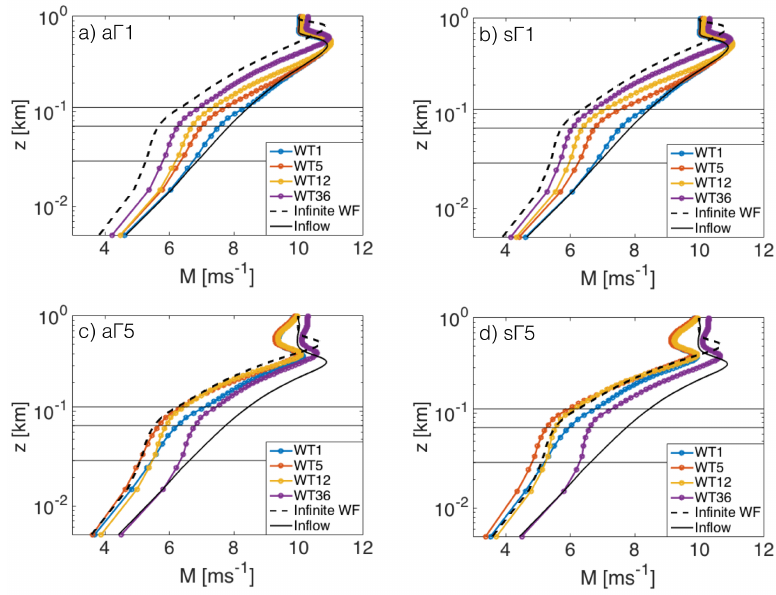
Figure 7. Vertical profiles of time- and spanwise-averaged velocity magnitude at the 1st, 5th, 12th and 36th turbine rows for the cases: ( a ) FS-a Γ 1; ( b ) FS-s Γ 1; ( c ) FS-a Γ 5; and ( d ) FS-s Γ 5. The black solid profile represents the velocity magnitude of the ABL inflow, and the black dashed profile represents the time- and horizontal-averaged velocity magnitude of the infinite wind farm with the same wind farm configuration. The black horizontal solid lines represent the turbine top-tip, hub and bottom-tip heights. The flow inside the aligned farm under Γ = 5 K/km shows a similar adjustment trend as the staggered farm flow under Γ = 5 K/km. It decelerates to its minimum at the 5th row, reaccelerates in the entrance and development region and becomes fully adjusted from the 12th row until